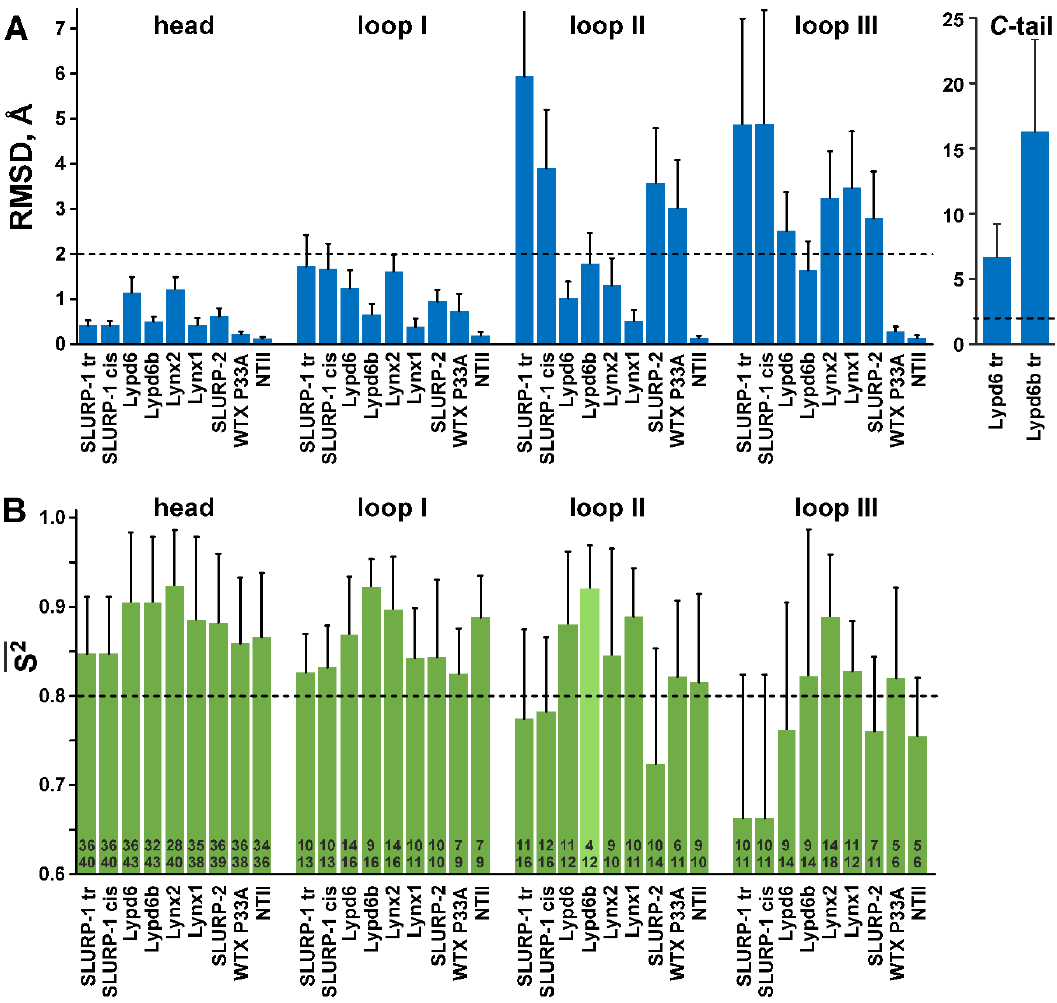
Figure 3. Qualitative comparison of NMR structure precision ( A ) with amplitude of ps–ns dynamics ( B ). ( A ). Mean backbone RMSD values (Å) in the NMR sets of the TFPs structures calculated over the loop regions, C -terminal ‘tail,’ and ‘head’ (other residues). The boundaries of the loop and C -terminal regions in the protein sequences are shown in Figure 1 with a gray background. Threshold value (RMSD > 2.0 Å, dashed line) shows the protein fragments with significant disorder. ( B ). Mean generalized order parameters (S 2 ) calculated over the loop regions, and ‘head’ of TFPs. The calculation of S 2 values in the C -terminal ‘tails’ was impossible, probably due to a very complex mobility model of the corresponding residues, which cannot be adequately described by models ##1–5. The threshold value (S 2 < 0.8, dashed line) shows the protein fragments with high-amplitude ps–ns dynamics. The numbers within the bars denote the length of the corresponding region (lower number) and number of residues with 15 N relaxation data available (upper number). The mean S 2 value in the Lypd6b loop II (light green) has the large degree of uncertainty due to lack of experimental data.